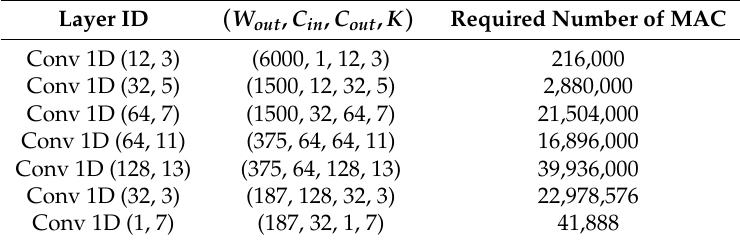
Table 8. The number of multiply-accumulate (MAC) of the convolutional layers at the encoder side. Layer ID ( W out , C in , C out , K )